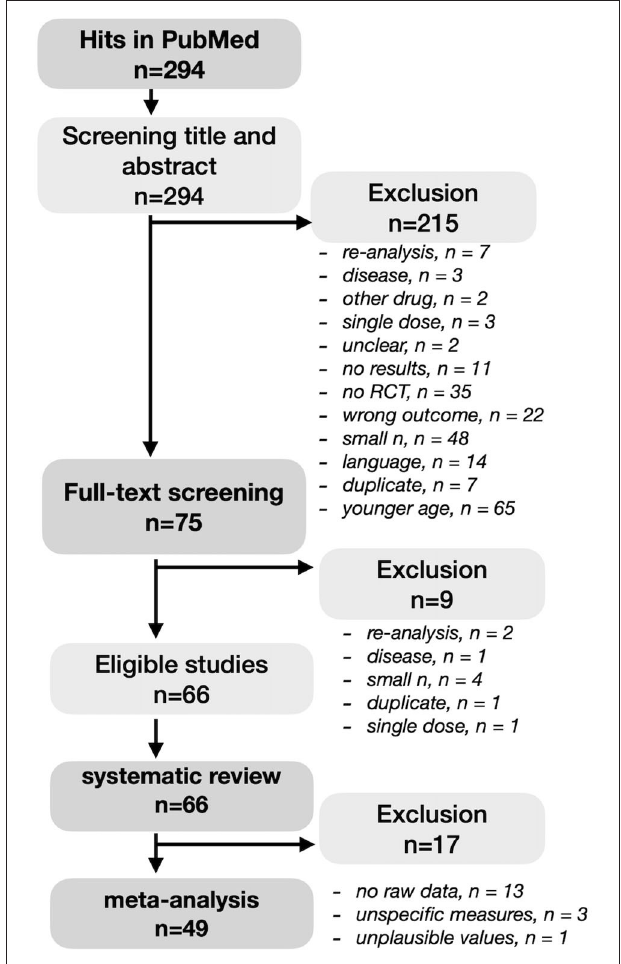
FIGURE 1 | PRISMA diagram of the systematic literature